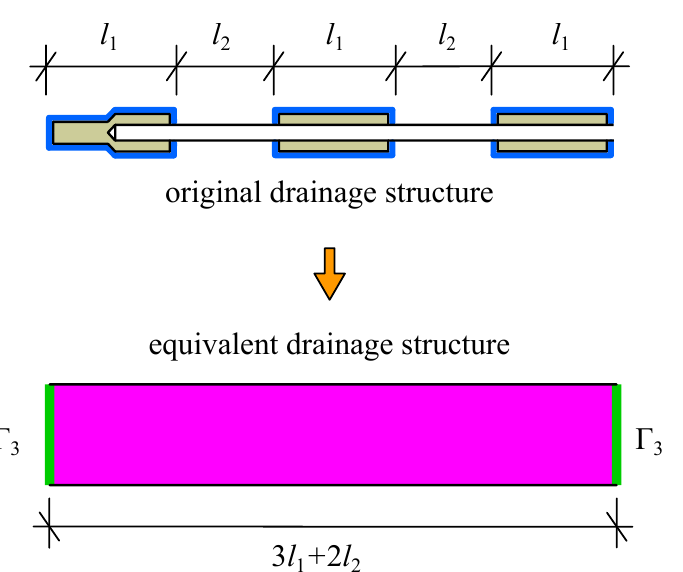
Figure 4. The suggested equivalent seepage analysis method for the drainage structure in Figure 2. Γ 3 is the saturated overflow boundary, expressed in Equation